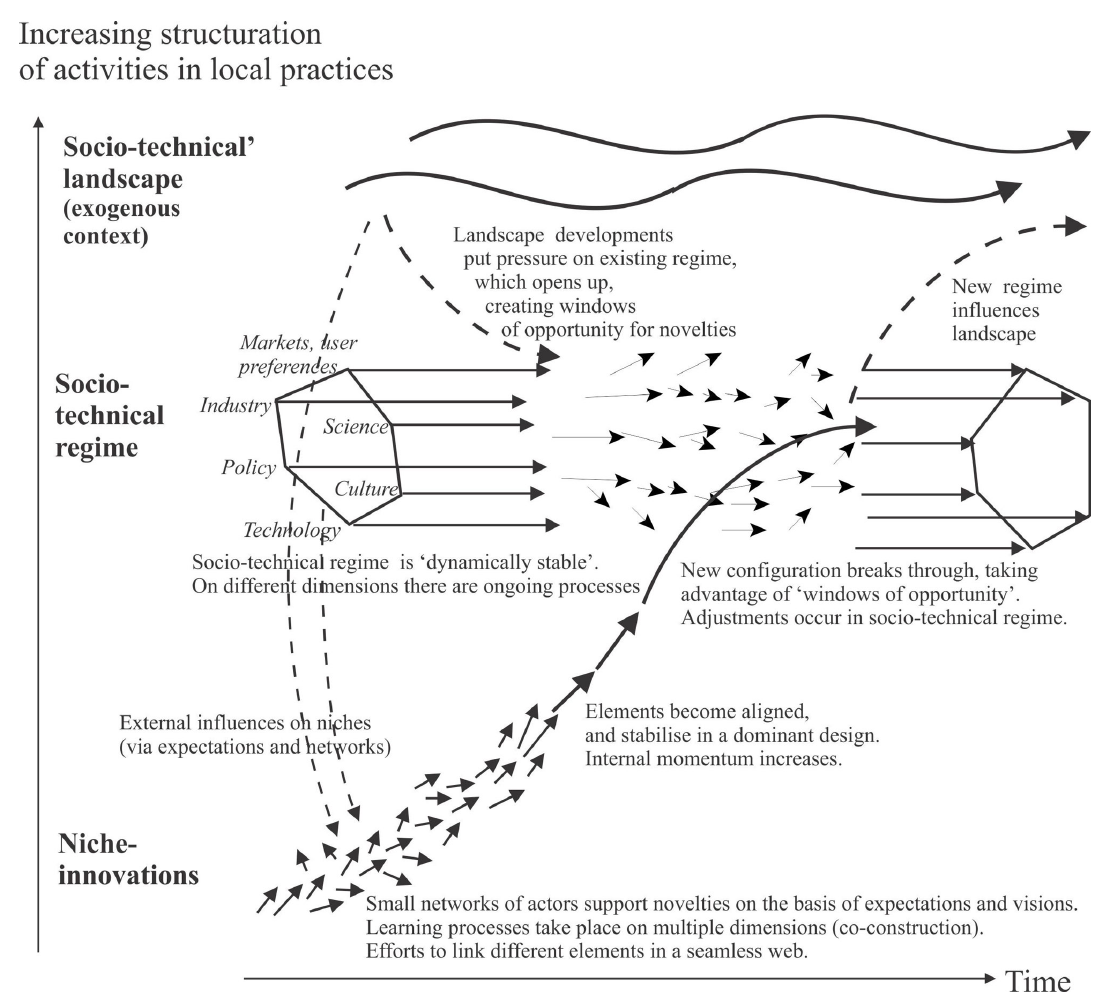
Fig. 5 . Transition model (Image source: Geels